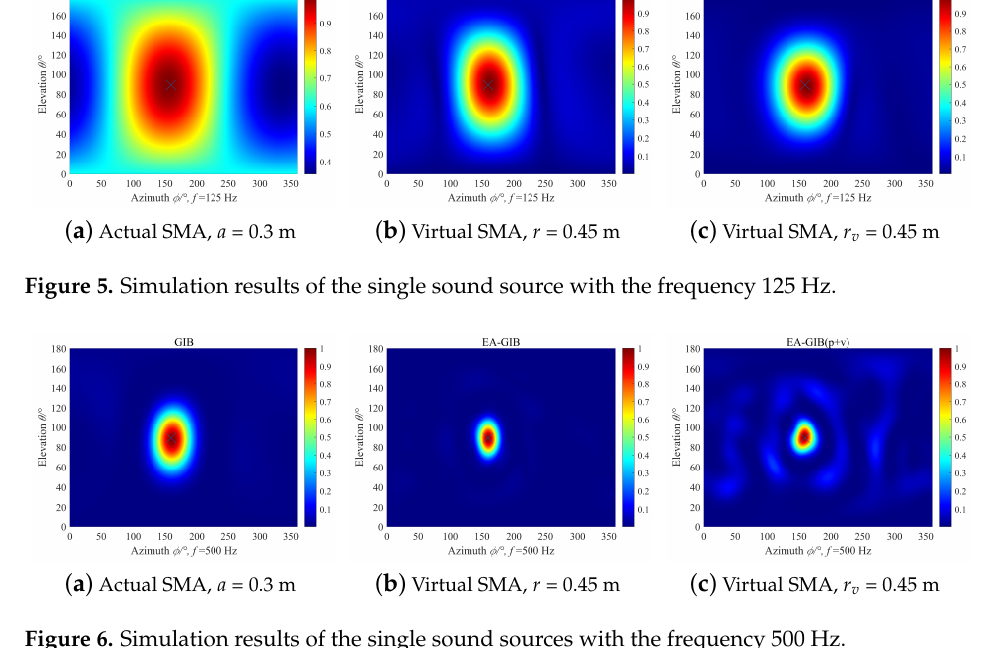
Figure 6. Simulation results of the single sound sources with the frequency 500 Hz.